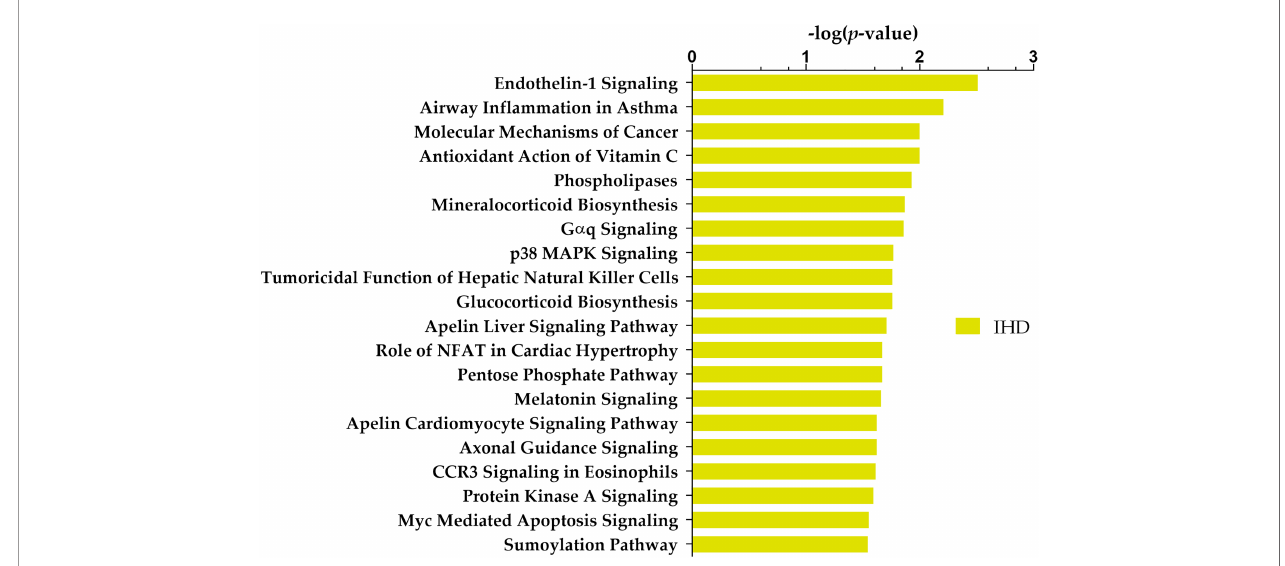
FIGURE 2 | Top 20 Ingenuity Pathway Analysis (IPA) canonical pathways most signi fi cantly changed in T2DM patients with IHD compared to individuals without IHD. The x-axis shows the -log of p -value calculated by the Benjamini-Hochberg (B-H)